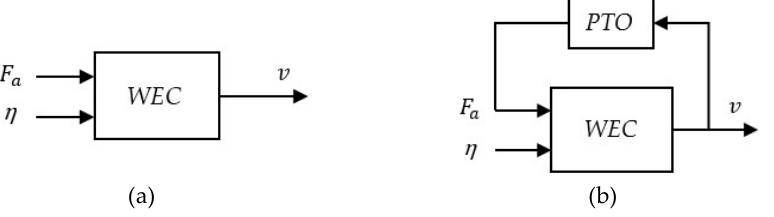
Figure 12. Block diagrams for the dynamic response of the WEC with an open-loop system ( a ) and a closed-loop system ( b ). closed-loop system ( b ).